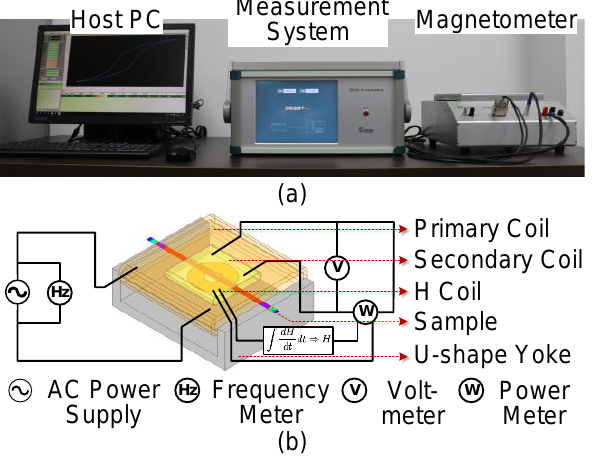
Figure 1. Sample preparation process. ( a ) Original ribbon and aluminium tooling, ( b ) W-EDM equipment and trajectory of molybdenum wire. ( c ) Prepared AA samples.